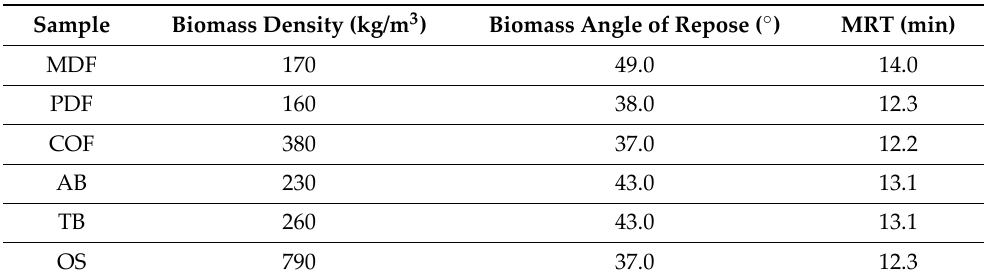
Table 5. Determination of the mean residence time (MRT) in the pilot‑scale